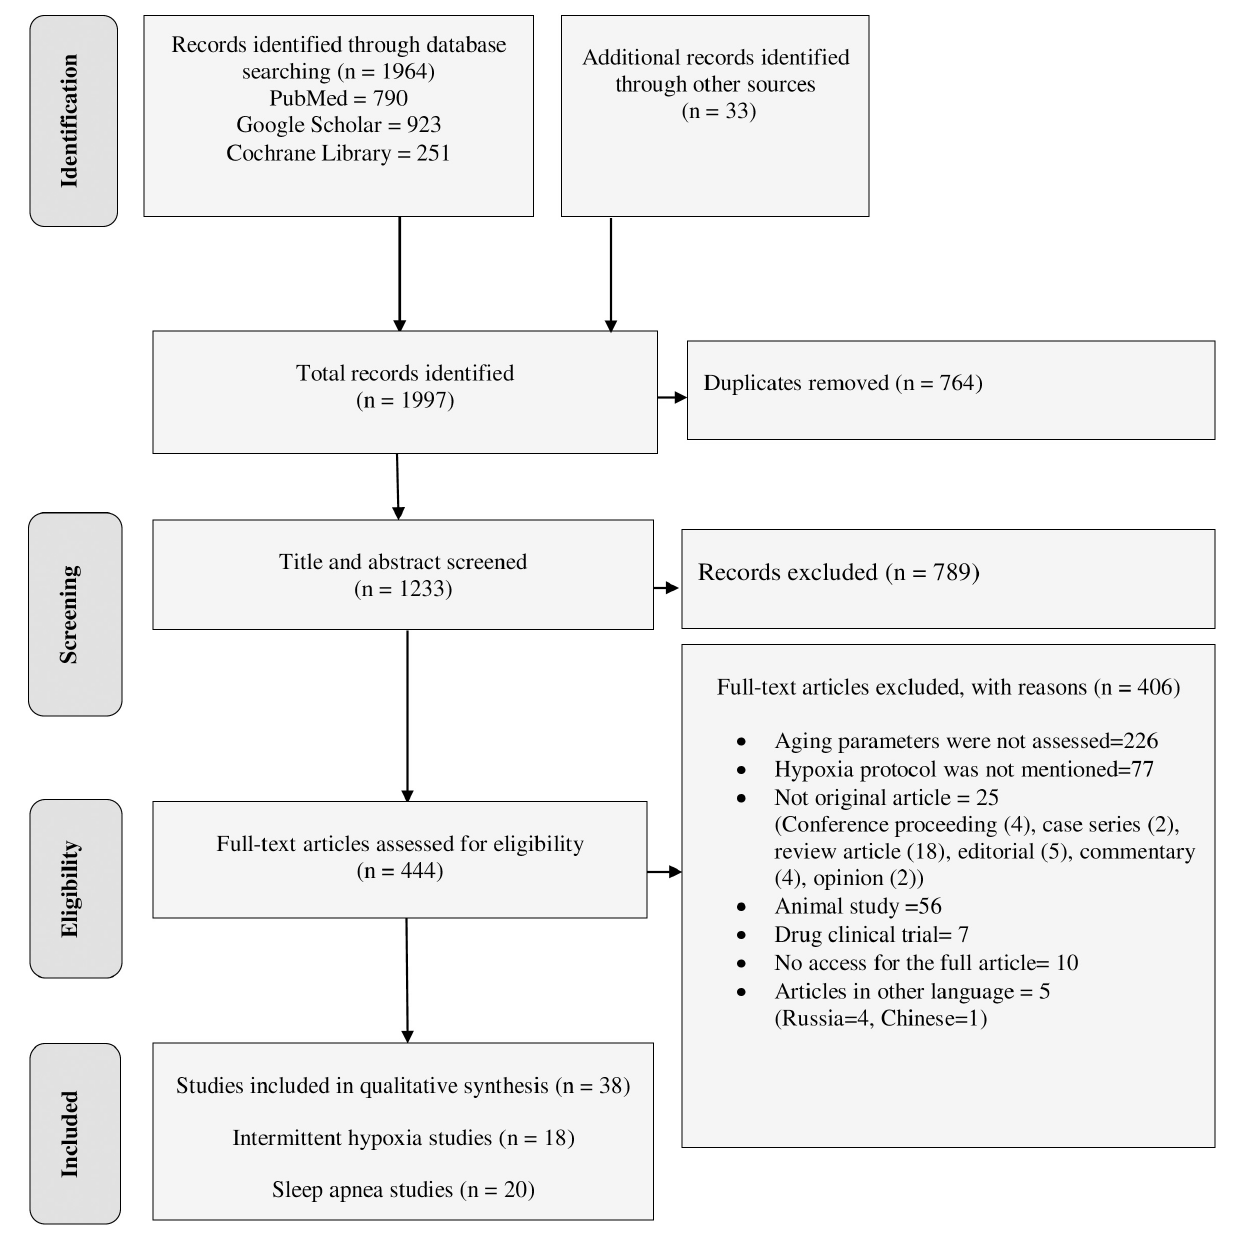
FIGURE 1 | PRISMA flow diagram shows the searching strategy and screening of eligible studies at different levels of the review process (Moher et al.,